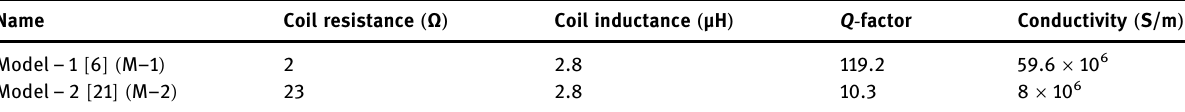
Table 2: Parameter of coil Name Coil resistance ( Ω )